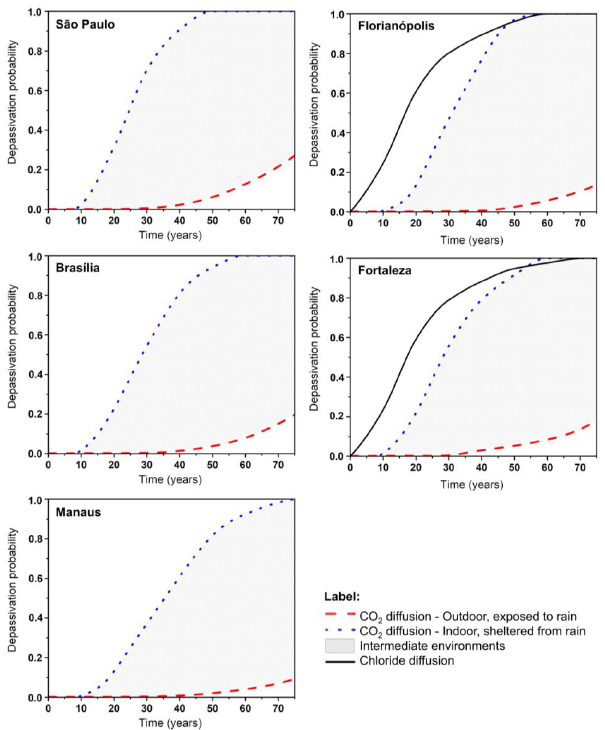
Figure 8. Depassivation probability due to CO 2 and Cl −